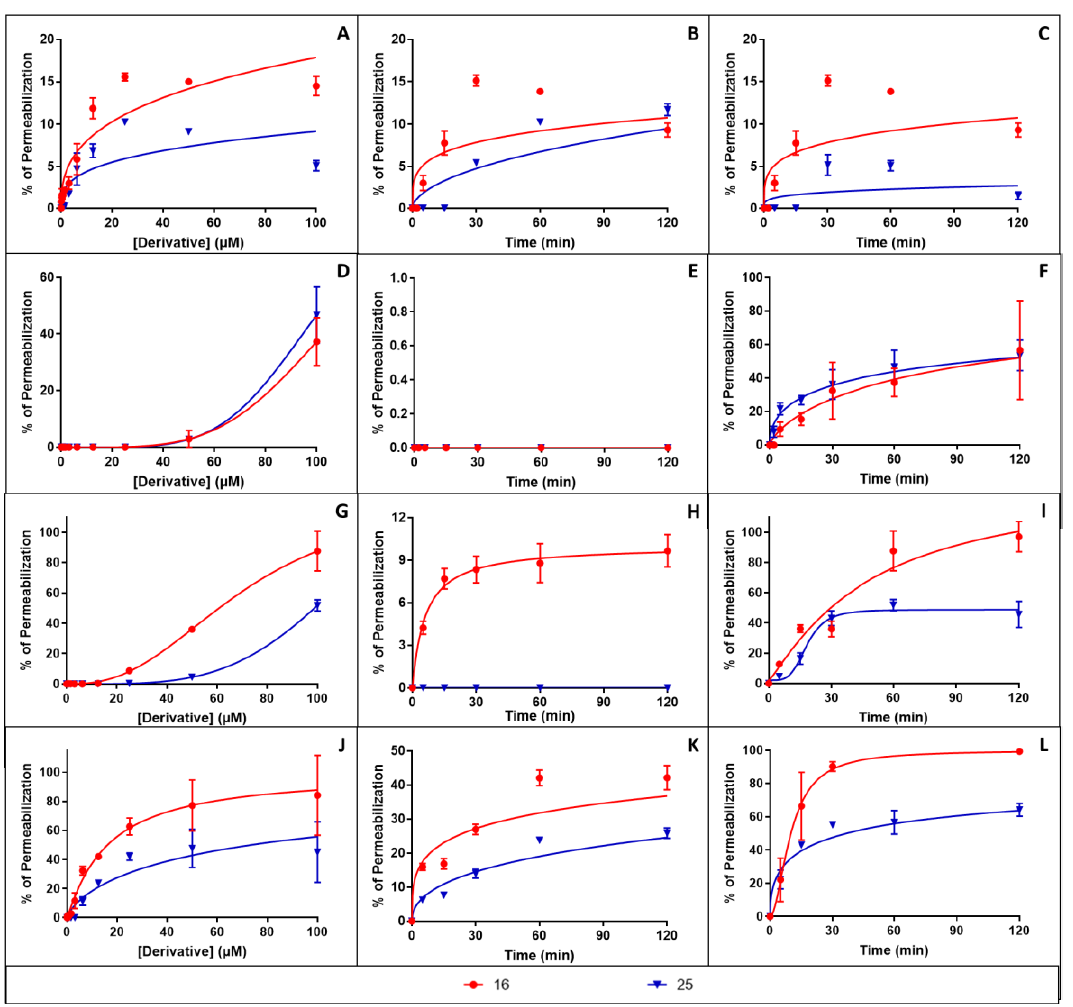
Figure 4. Concentration and time-dependent effect of berberine derivatives on the bacterial membrane integrity. The dose- and time-dependent effects of compounds 16 and 25 on bacterial membrane integrity were studied using B. subtilis ( A – C ), H. pylori ( D – F ), S. aureus ( G – I ) or V. alginolyticus ( J – L ). Graphs ( A , D , G , J ) show the dose-dependent effect of 60 min incubation at 37 °C with increasing concentrations of derivatives. Graphs ( B , E , H , K ) show the time-dependent effect at 37 °C of derivative at 4-times their MIC. Graphs ( C , F , I , L ) show the time-dependent effect at 37 °C of derivative at 100 µM. In all cases, results were expressed as percentage of membrane permeabilization using CTAB at 300 µM as positive control giving 100% permeabilization. Results corresponding to means ± SD ( n = 3) were fitted using the Graph Pad Prism software.